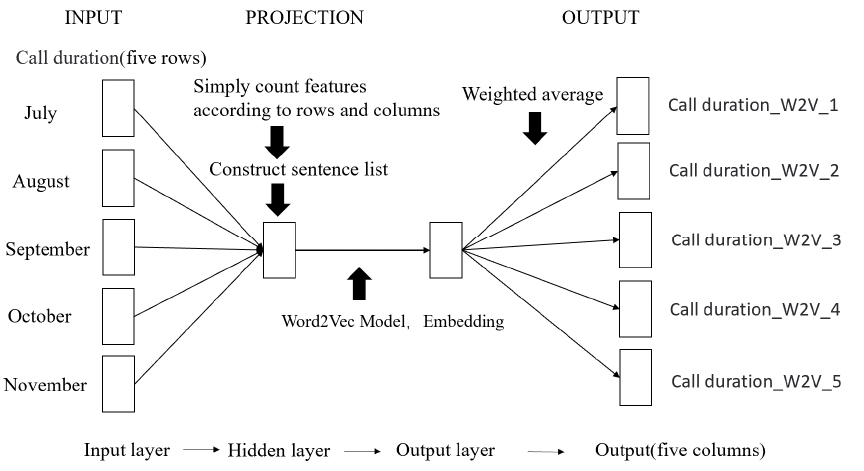
Figure 2. Flowchart of Word2Vec feature processing.